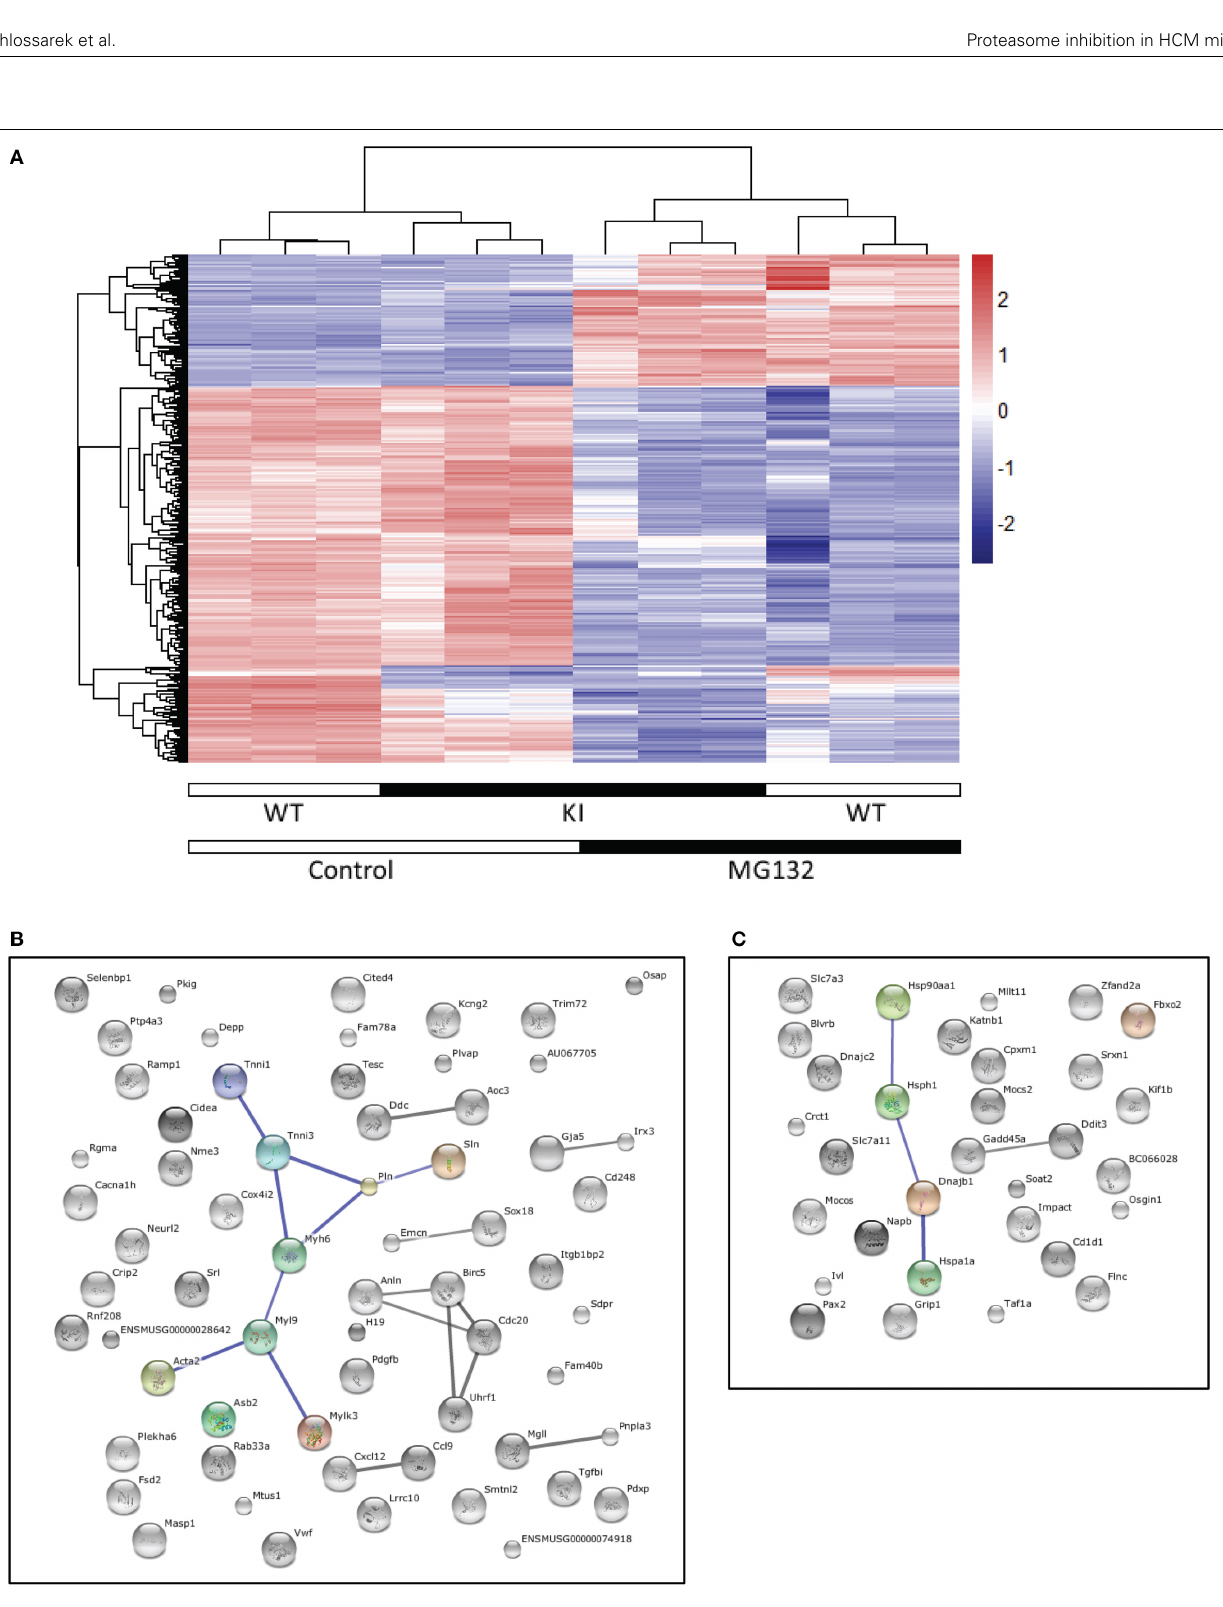
String networks of four-fold and significant differentially expressed (5% FDR) genes commonly regulated in KI and WT cardiac myocytes [ N = 103, 68 down (B) and 35 up (C) ]. Known and predicted protein interactions including direct (physical) and indirect (functional) associations are visualized in a network. The size of the connecting lines represents the impact of the connection. Only high confidence String interactions are